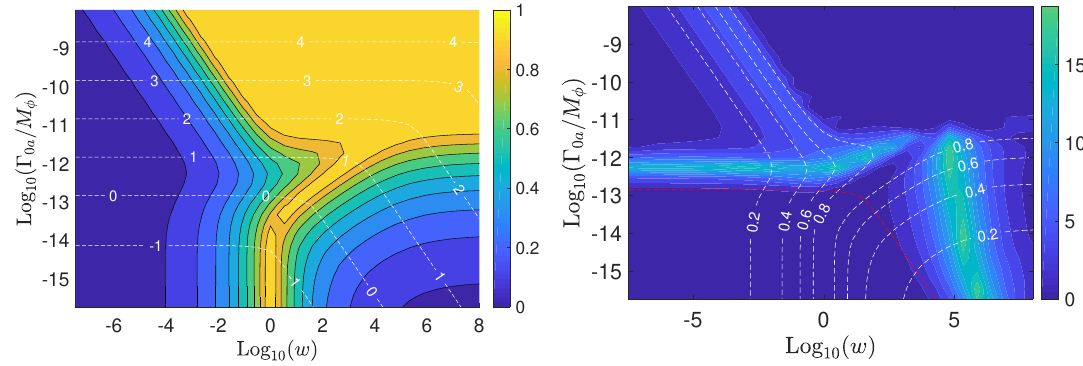
Figure 12. Left panel : contours of the (cid:12)nal temperature ratio obtained numerically, x f;n = T b =T a , shown in color, for an in(cid:13)aton coupled to scalars in sector a and fermions in sector b . The white dashed lines show contours of log ( T rh =M (cid:30) ). Right panel : contours of relative fractional 10 discrepancy, j x f;a (cid:0) x f;n j =x f;n , where x f;a is the analytic estimate of eq. (4.16) with eq. (4.33), in percent. The white dashed contours depict x f;n and the red dashed line marks T rh = M (cid:30)